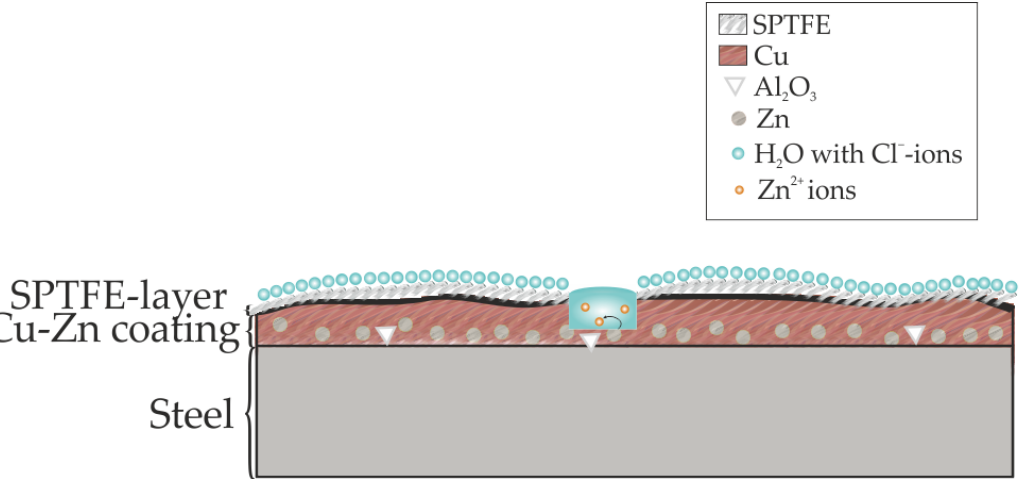
Figure 13. The proposed mechanism of the protective action of the composite coating obtained using the cold spray method. the cold spray